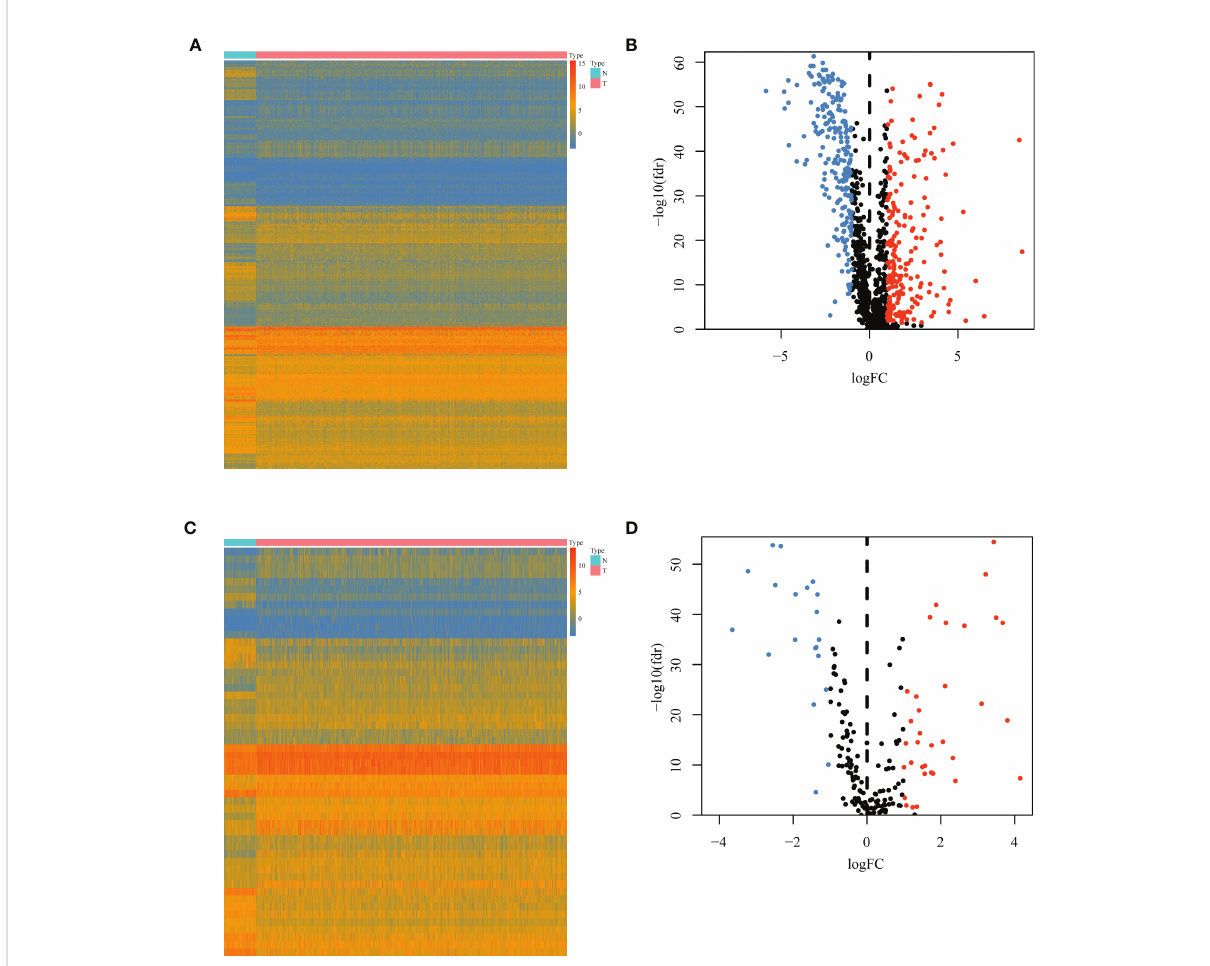
FIGURE 2 Differential immune or in fl ammation-related gene expression analysis in the TCGA-BRCA training cohort. (A) Heatmap and (B) volcano plot of 1,094 immune-related genes in the TCGA-BRCA training cohort showing differential expression between cancer and normal samples. (C) Heatmap and (D) volcano plot of 180 in fl ammation-related genes in the TCGA-BRCA training cohort identifying DEGs between cancer and normal tissues. N, normal tissues; T, tumor tissues; DEGs, differentially expressed